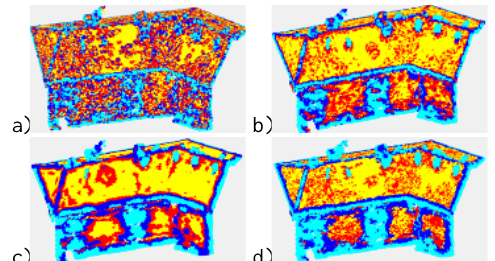
Figure 2. Unsupervised segmentation based on 3D features extracted from different scales (ground truth refers to figure 3). Planarity is calculated based on different sizes of neighboring points. a): 20, b):100, c):500, d): {20, 100,